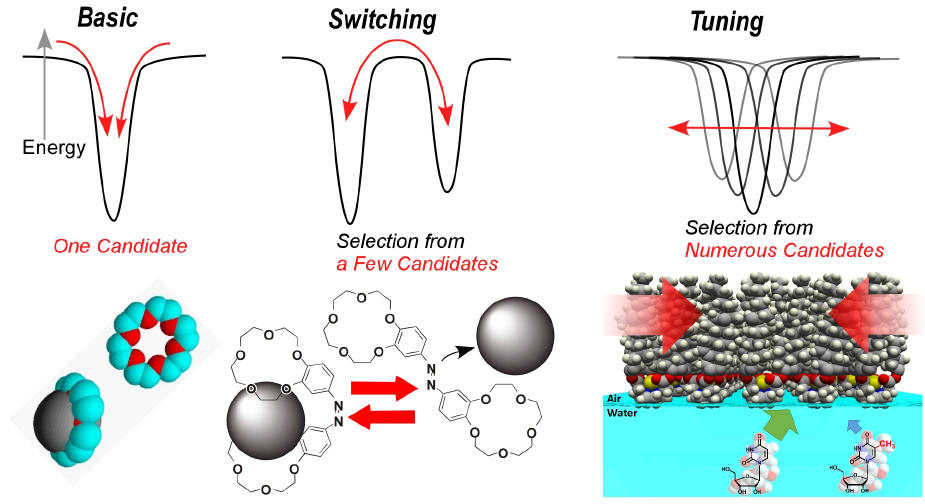
Figure 19. Summary the modes of molecular recognition: basic, switching, and tuning.